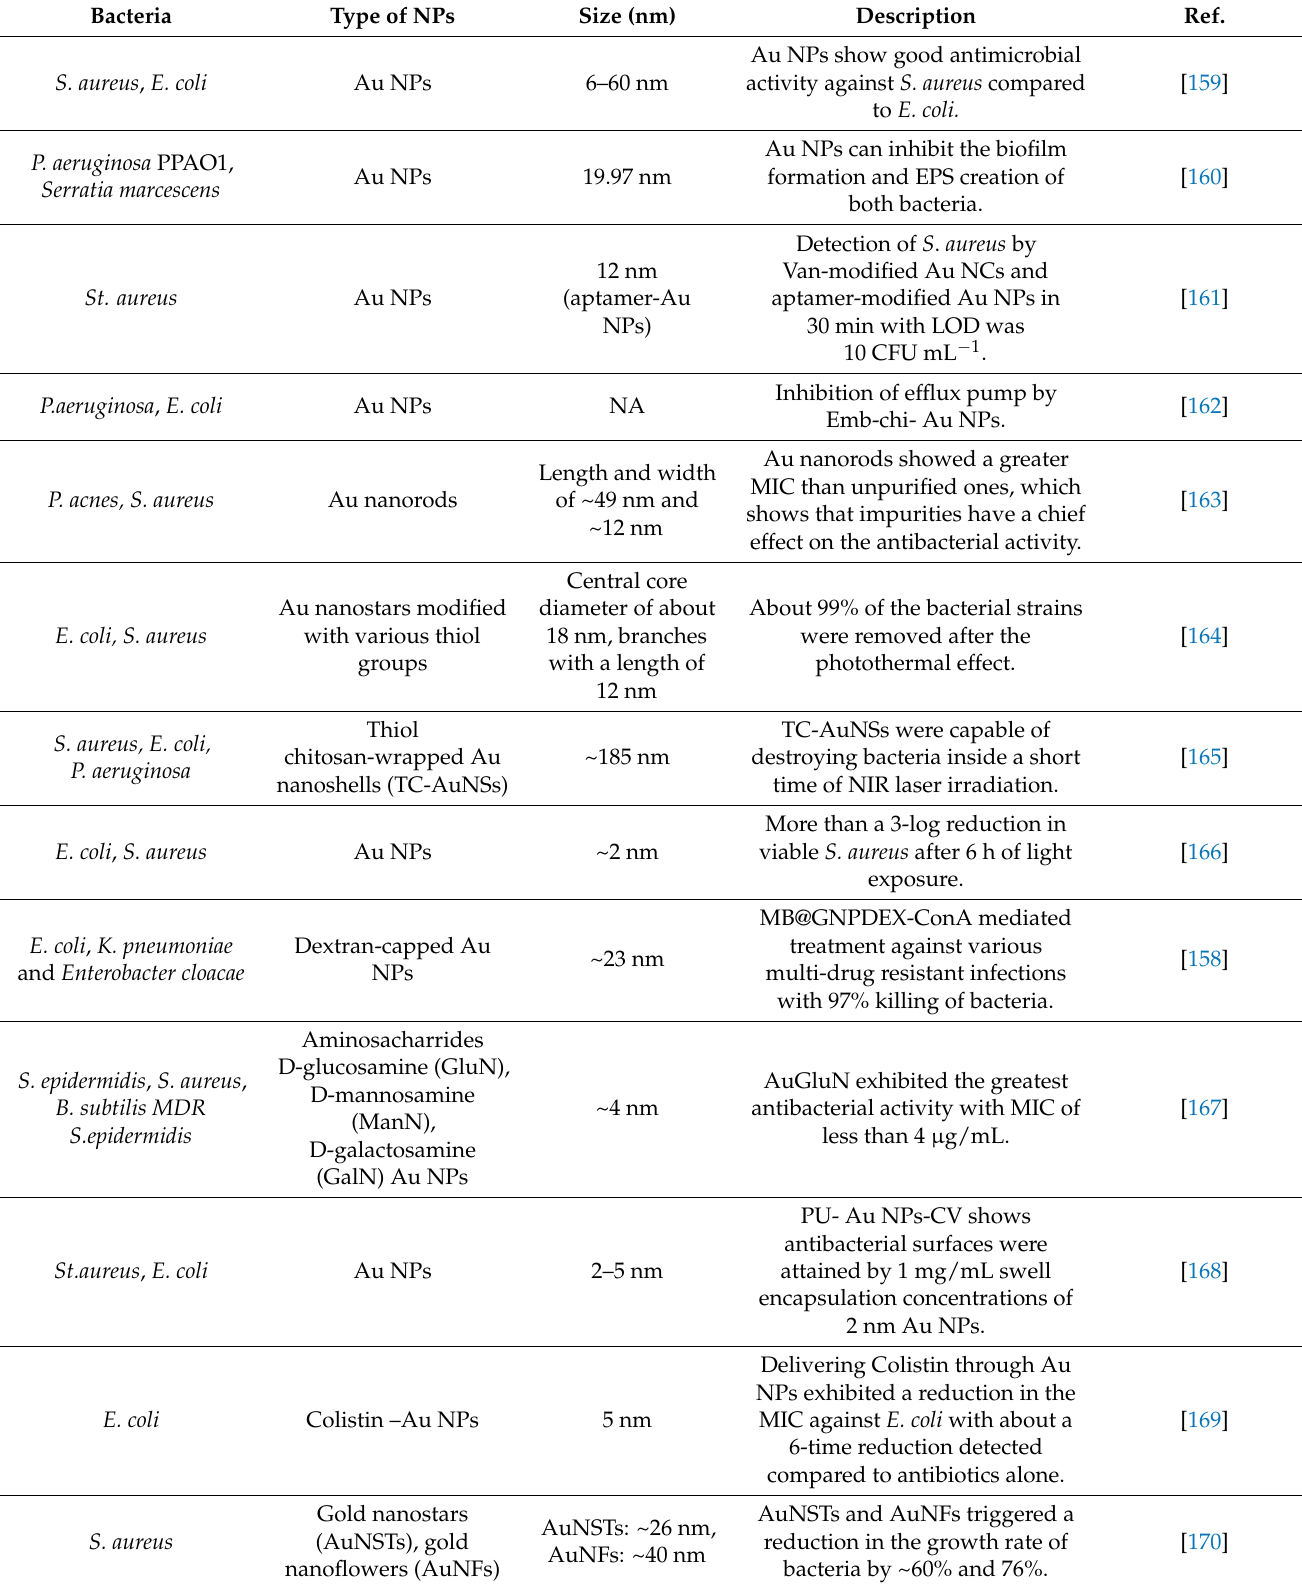
Table 2. Other examples of the application of Au NPs in antimicrobial resistance activity (AMR).